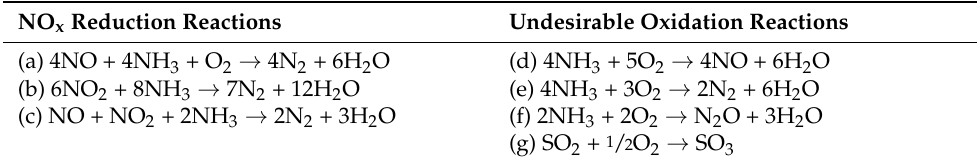
Table 1. Main global reactions occurring in an